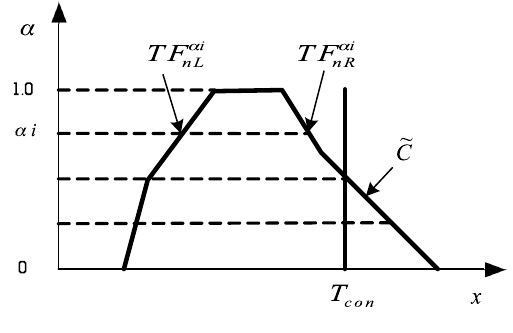
Figure 2. “The overall project completing fuzzy time vs. project contract time